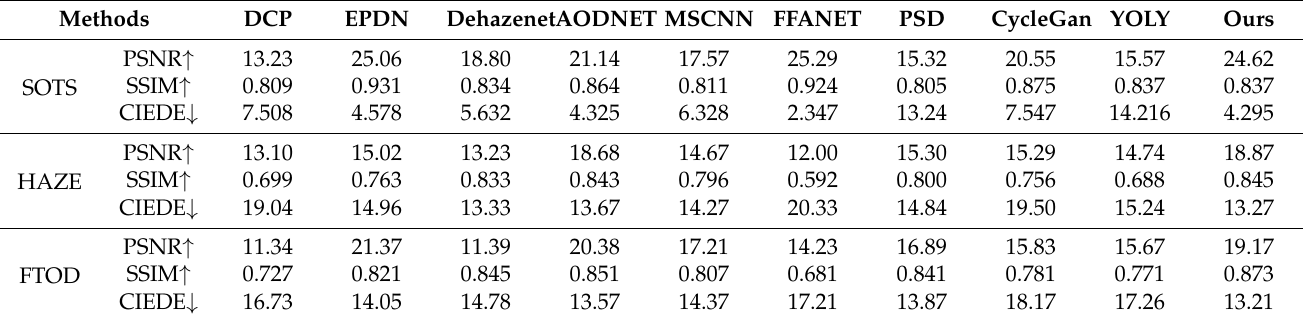
Table 2. Quantitative evaluations on the benchmark dehazing datasets. ↑ and ↓ mean the better methods should achieve higher/lower score of this